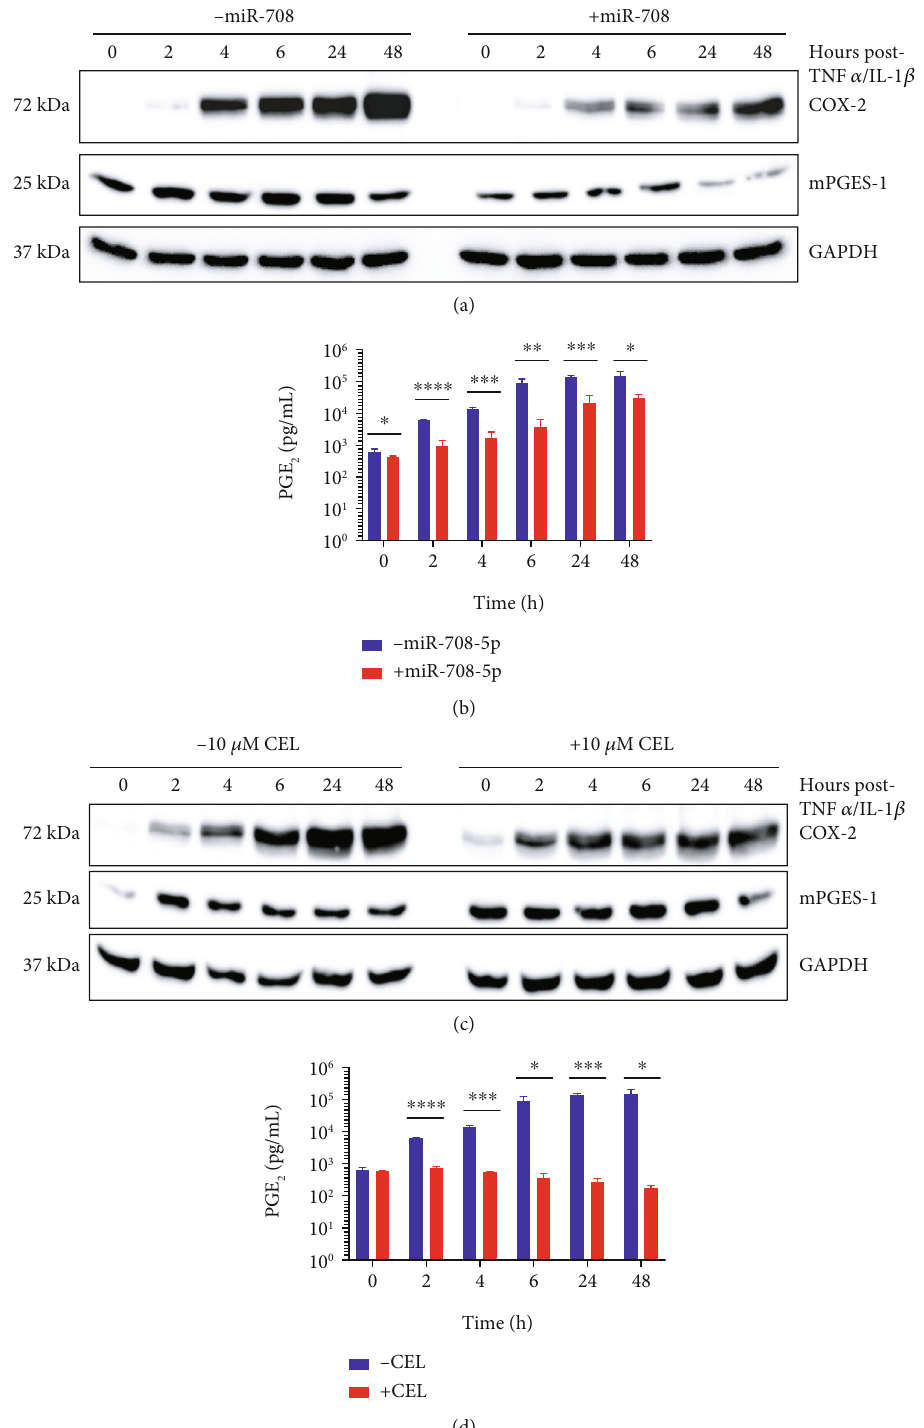
Figure 3: miR-708 suppresses TNF α /IL-1 β -induced arachidonic acid signaling partially through a positive feedback loop in diseased lung cells. (a) Representative western blot examining COX-2 and mPGES-1 protein expression in A549 cells transiently transfected with mock (left) or 25 nM miR-708 (right) in combination with TNF α /IL-1 β for 0 – 48 hours. (b) ELISA measuring exogenous PGE levels in A549 2 cells transiently transfected with mock (blue) or 25 nM miR-708 (red) and treated with TNF α /IL-1 β for 0 – 48 hours. (c) Representative western blot examining COX-2 and mPGES-1 protein expression in A549 cells cotreated with vehicle (left) or 10 μ M CEL (right) and TNF α /IL-1 β for 0 – 48 hours. (d) ELISA measuring exogenous PGE levels in A549 cells cotreated with vehicle (blue) or 10 μ M CEL (red) 2 and TNF α /IL-1 β for 0 – 48 hours. ∗ p < 0 : 05 , ∗∗ p < 0 : 01 , ∗∗∗ p < 0 : 001 , and ∗∗∗∗ p < 0 : 0001 ; n ≥ 3